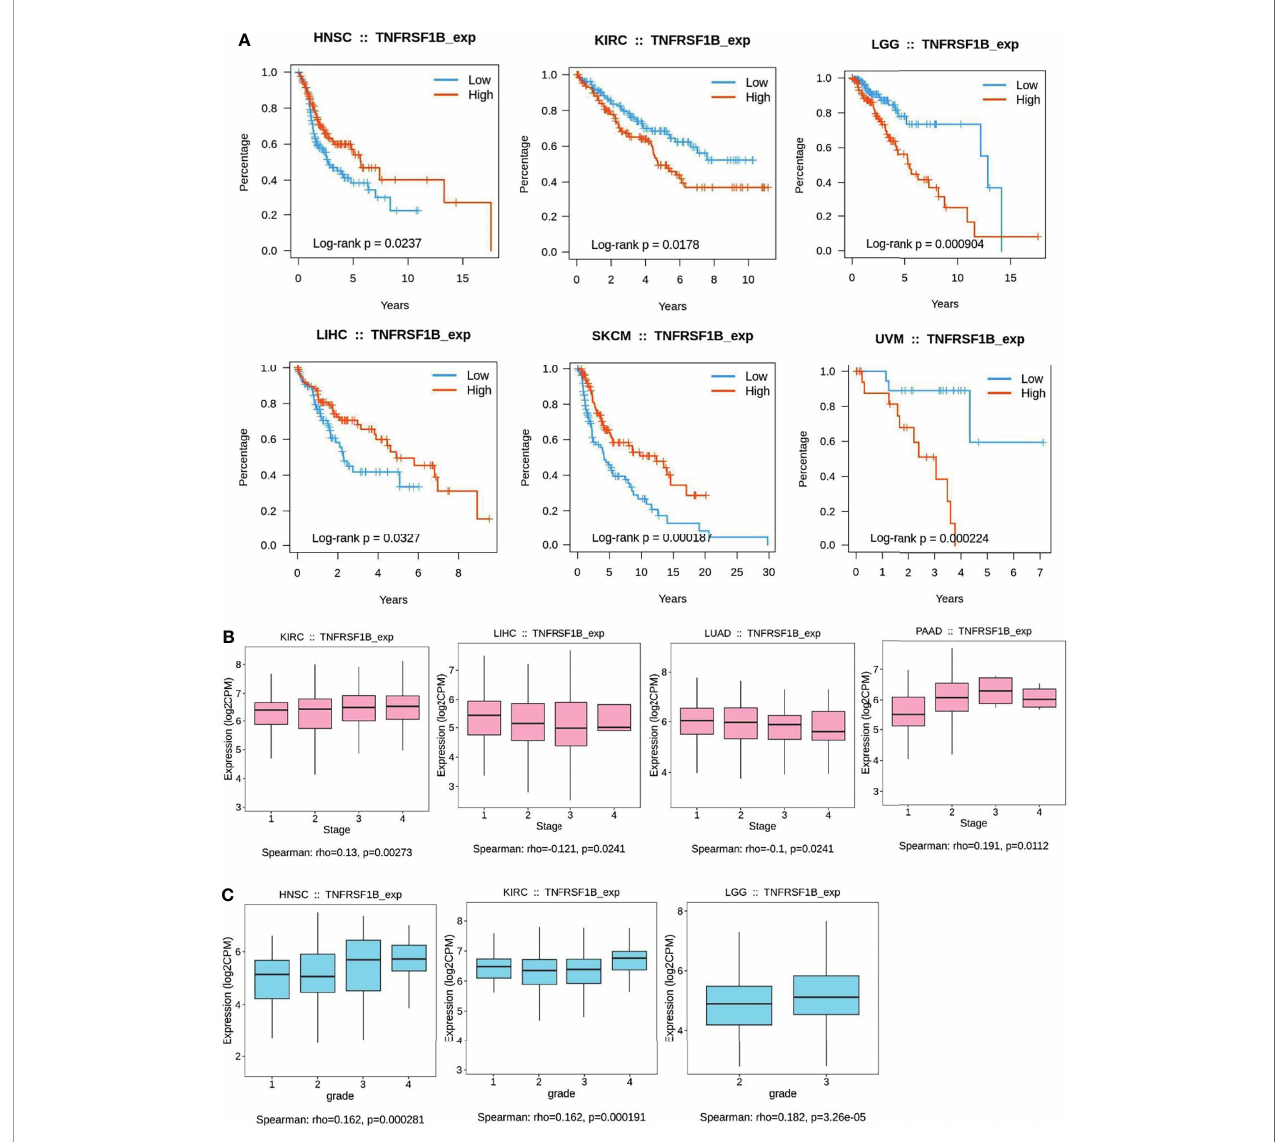
FIGURE 3 | Kaplan – Meier curves to demonstrate the clinic pathological signi fi cance of TNFR2. (A) Analysis of the relationship between the expression of TNFR2 and the overall survival (OS) of various cancer patients from TCGA database through TISIDB (P < 0.05). (B, C) Analysis of the relationship between TNFR2 expression and tumor stage and grade through TIBIS prediction (P <